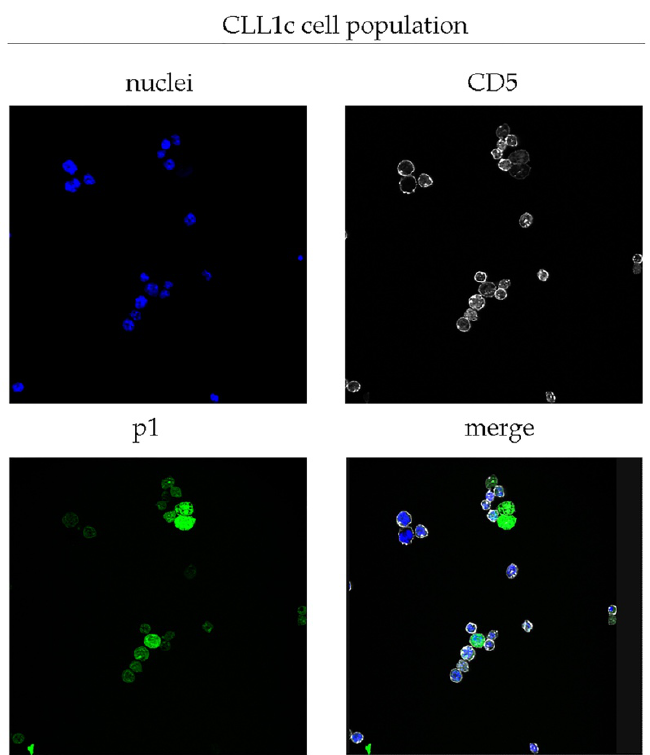
Figure 1. Representative confocal images of total CLL cells from CLL1c patient. Cells were labeled with DAPI to detect the nuclei (blue), anti CD5 (white) to identify the leukemic population and p1 peptide (green). The analysis was performed using a Leica TCS SP2 confocal microscope at 40 × magnification.